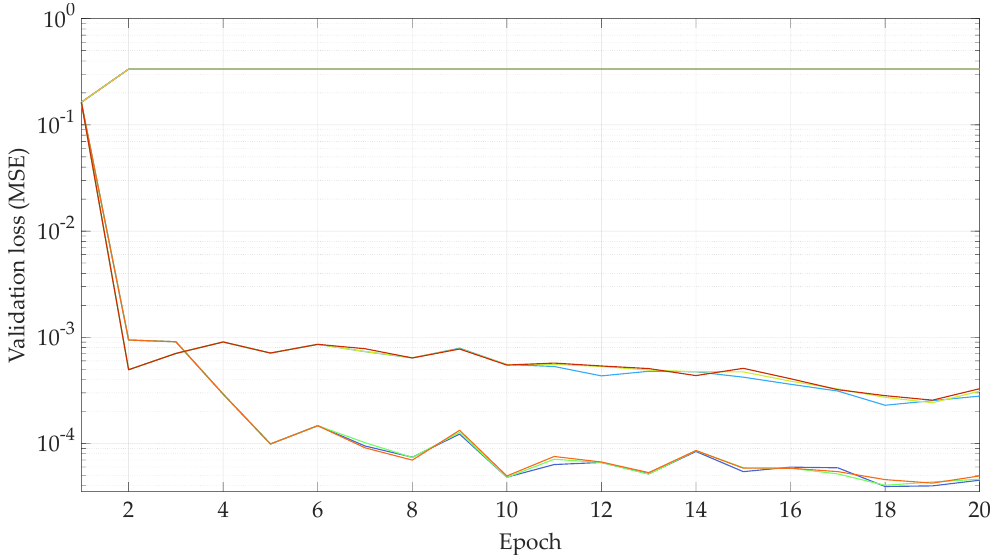
Figure 14. Validationloss with respect of the validation epoch for the hyper-parameter optimization. [ lr max = 10 − 3 ,drop = 1.1 ] , [ lr max = 10 − 4 ,drop = 1.1 ] , [ lr max = 10 − 5 ,drop = 1.1 ] , [ lr max = 10 − 3 ,drop = 1.3 ] , [ lr max = 10 − 4 ,drop = 1.3 ] , [ lr max = 10 − 5 ,drop = 1.3 ] , [ lr max = 10 − 3 ,drop = 1.5 ] , [ lr max = 10 − 4 ,drop = 1.5 ] , and [ lr max = 10 − 5 ,drop = 1.5 ]